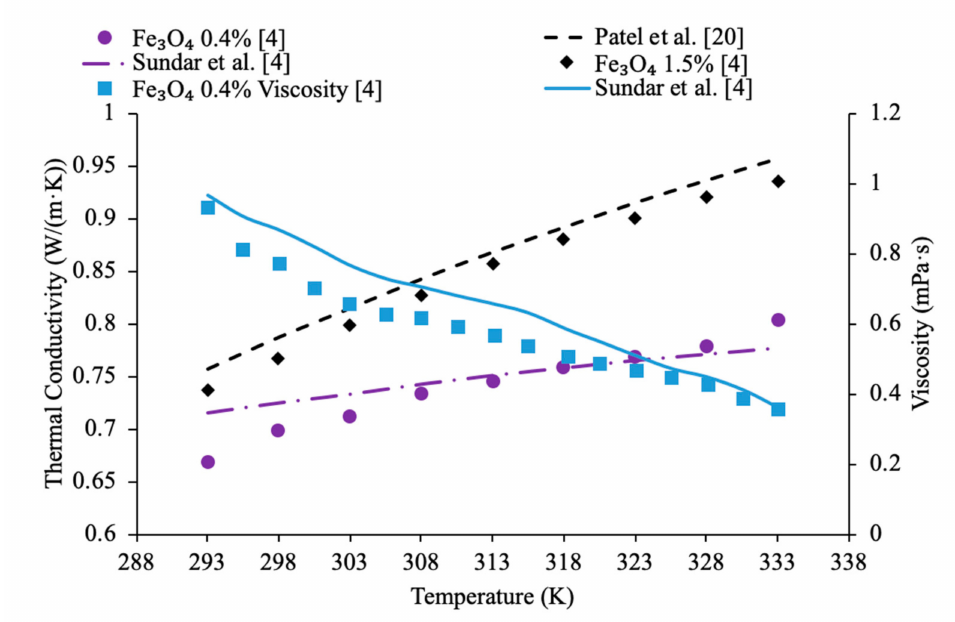
Figure 43. Thermal conductivity (increasing with temperature) and viscosity (decreasing with temperature) for 13 nm Fe 3 O 4 –water nanofluids at 0.4% and 1.5% [4] in comparison to various theoretical models